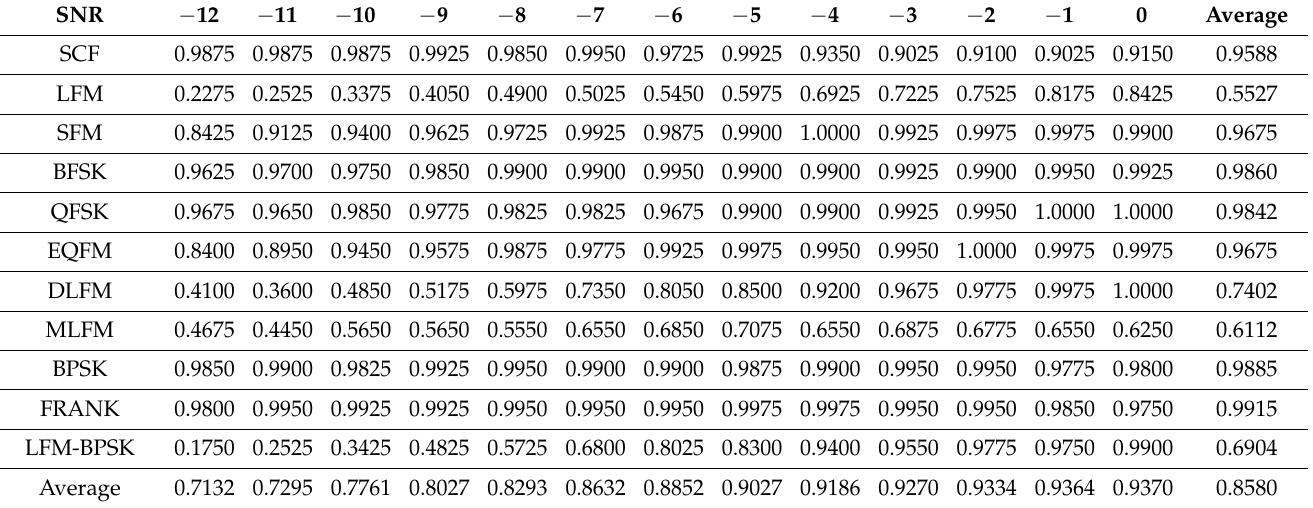
Table A25. Semi-supervised classification results with the datasets in Situation Dataset 5 ( d = 0.5 decreasing